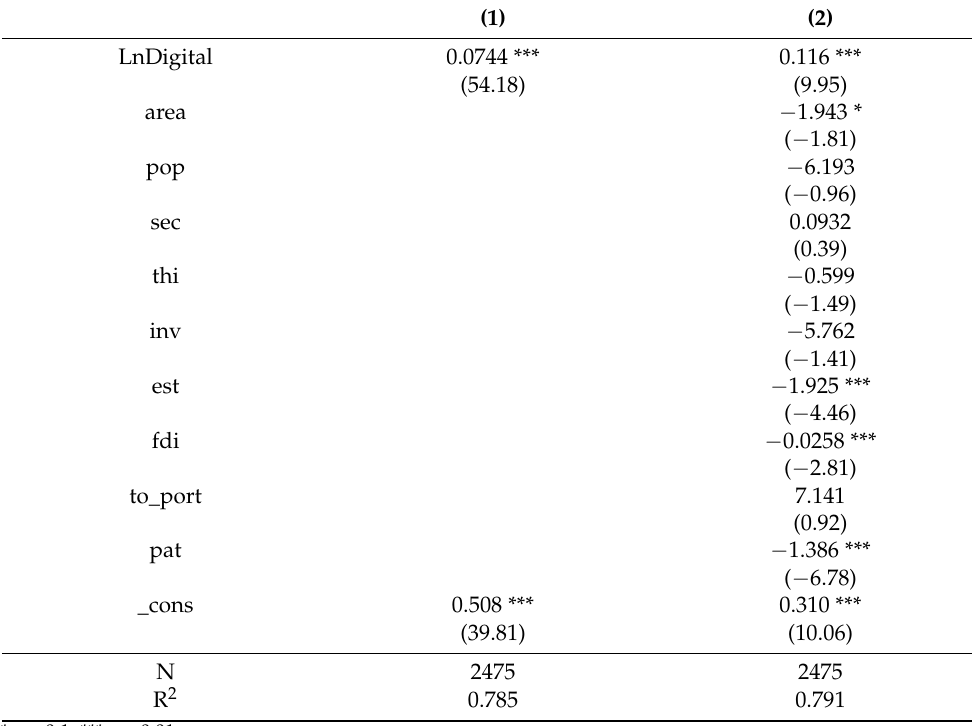
Table 7. Regression of Instrumental